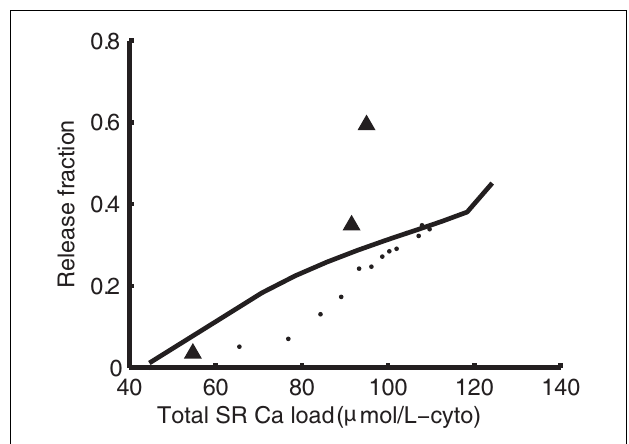
FIGURE 3 | Sarcoplasmic reticulum load-dependence of fractional release. Model SR load vs. fractional release (solid line) compared to experimental data from Shannon et al. (2000) in rabbit (dots) and Bassani et al. (1995) in ferret